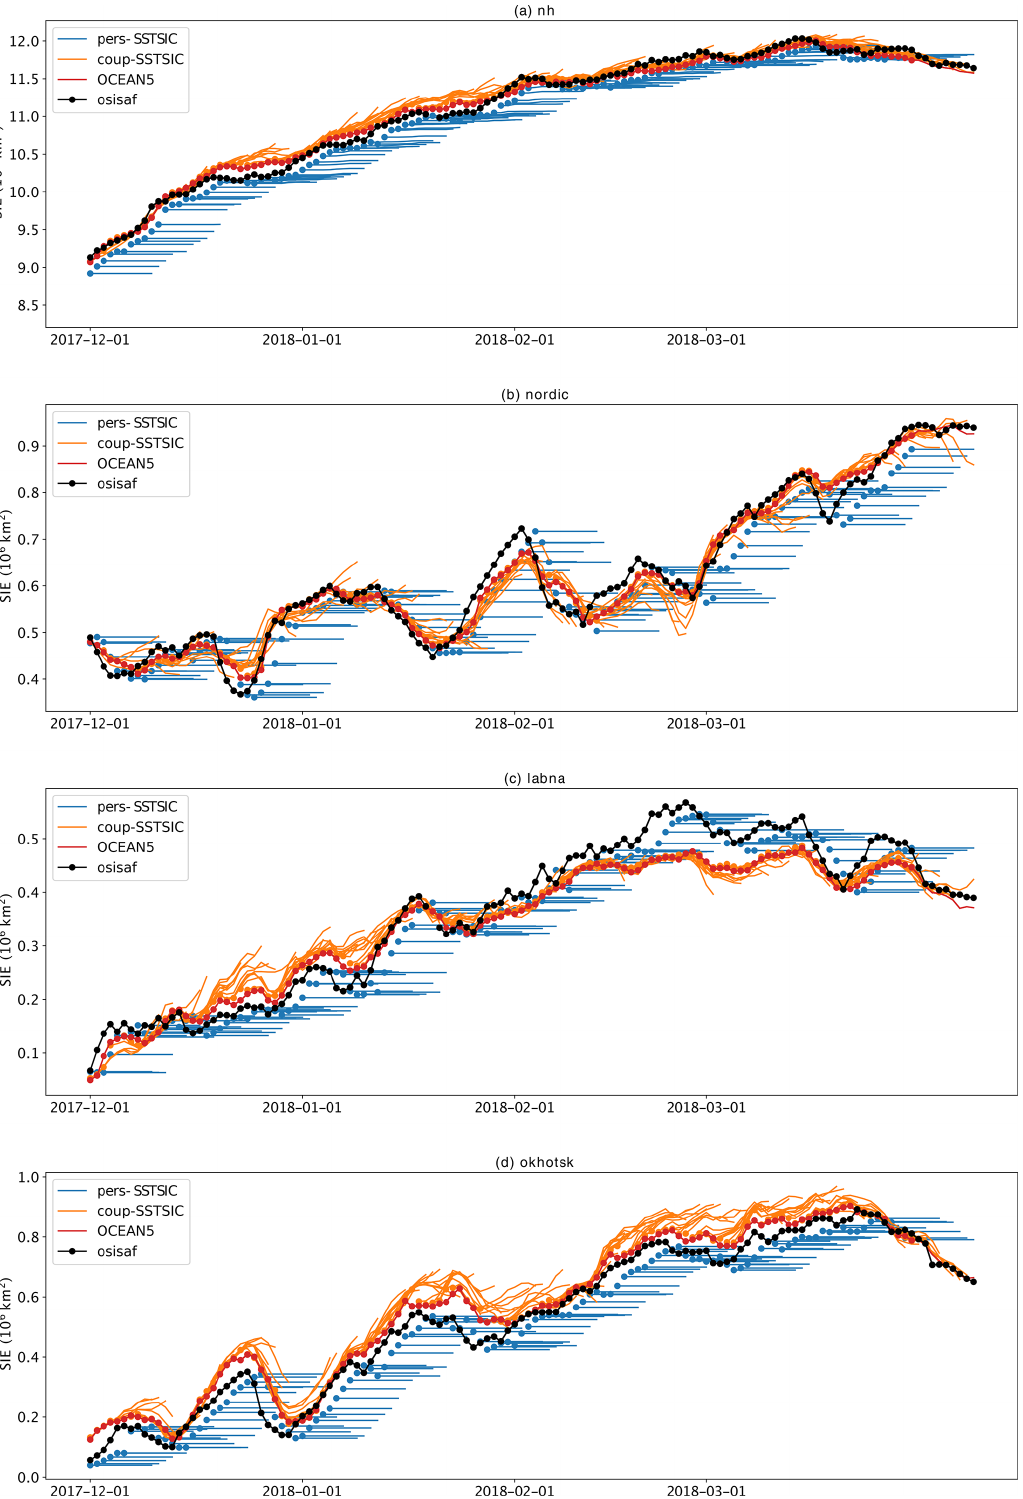
Figure 2. Time series of sea ice extent in the Northern Hemisphere (a) , Nordic Seas region (b) , Labrador and North-East Atlantic (c) , and the Sea of Okhotsk (d) . The regions are shown in Fig. 1. Daily mean sea ice extent for each 10d forecast and each analysis product is plotted with day 0 indicated by a dot marker. The date is given in the format